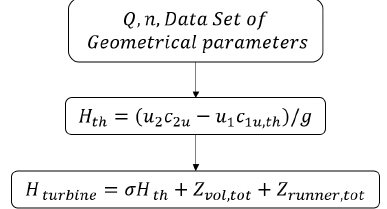
Figure 1. Flow chart of the proposed model.